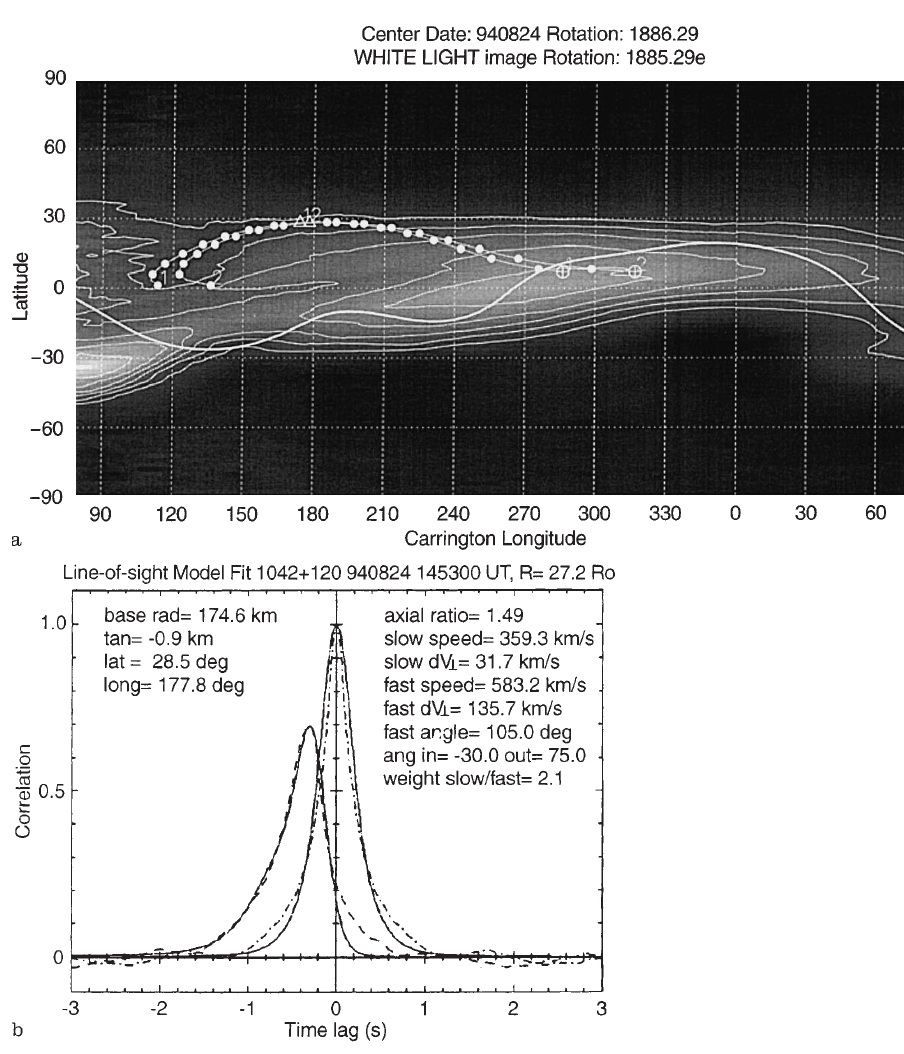
Fig. 9. a White-light map showing the ray-path for an EISCAT observation of 1042+120 on 24 August 1994, projected down to 1.7 R with assumed velocities of 750 km s ) 1 (line 1) and 325 km s ) 1 (line 2). The white line stretching across the whole of the map is the magnetic equator, calculated from Stanford magnetic data. b EISCAT correlation functions for the observation shown in a . The